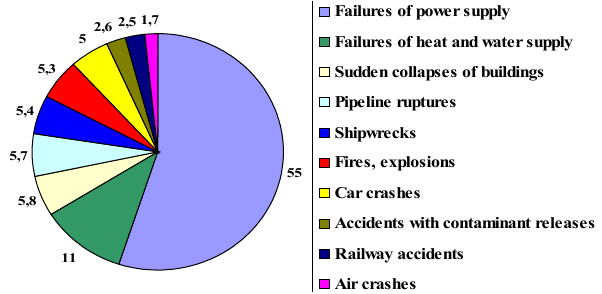
Fig. 3. Proportion of technological accidents triggered by natural hazards (in percent)